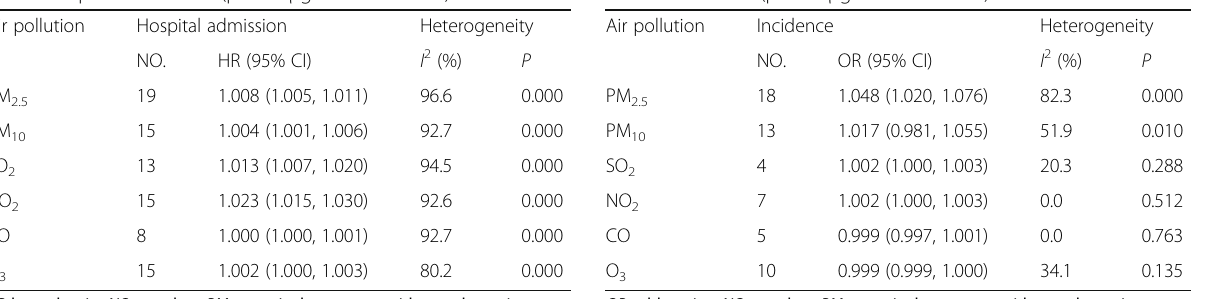
Table 2 Association between exposure to air pollution and Table 3 Association between exposure to air pollution